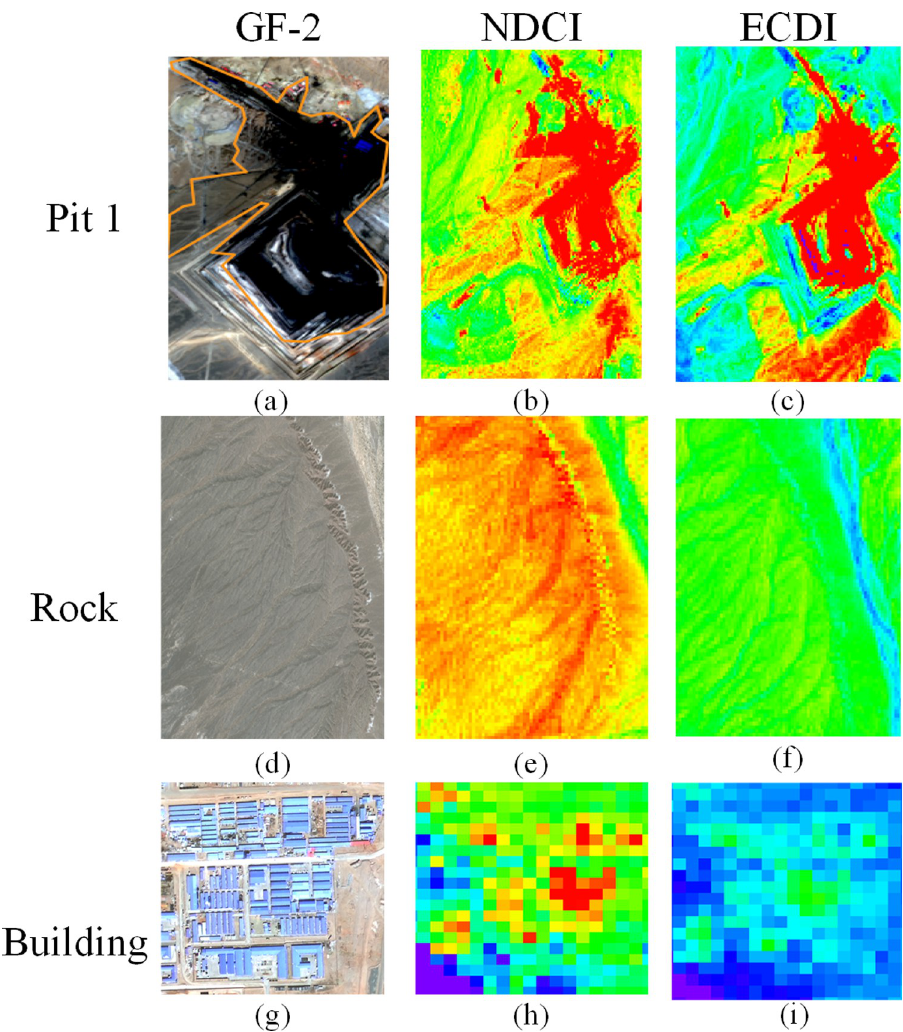
Fig 3. Comparison of GF-2, NDCI, and ECDI images containing coal dust, rocks, and